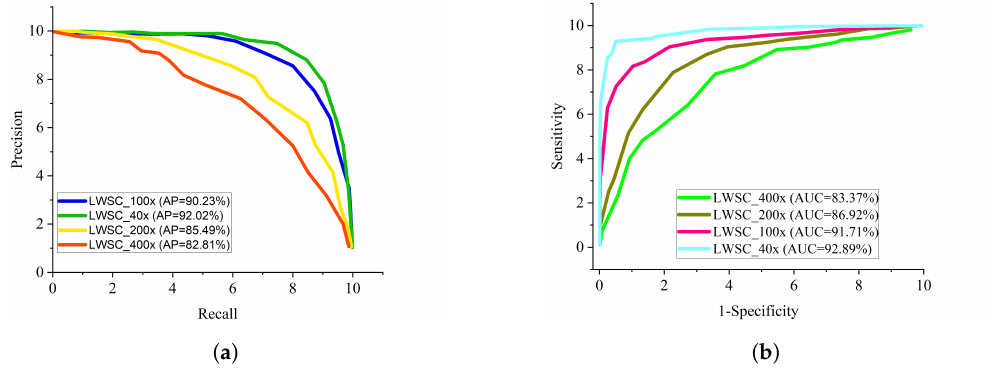
Figure 5. Comparison report of the BC classification for two classes. ( a ) Precision–recall curve for different magnification factors for two classes of BC classification; ( b ) ROC curve for different magnification factors for two classes BC classification.